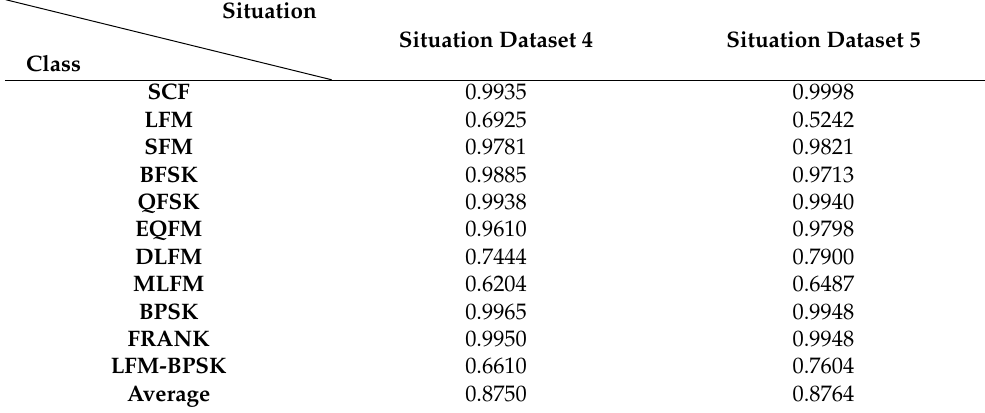
Table 7. The semi-supervised classification accuracy of our proposed method for the classes with the datasets in Situation Dataset 4 and Situation Dataset 5.